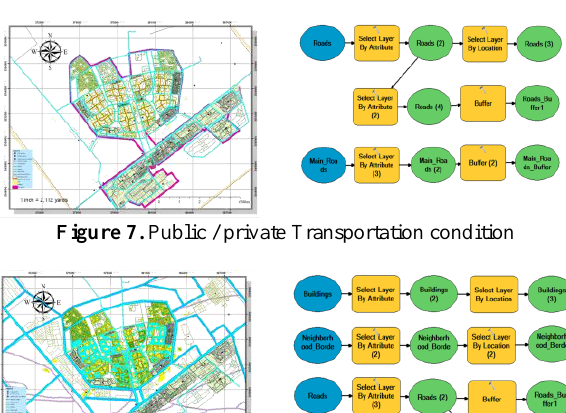
Figure 6. Sanitation